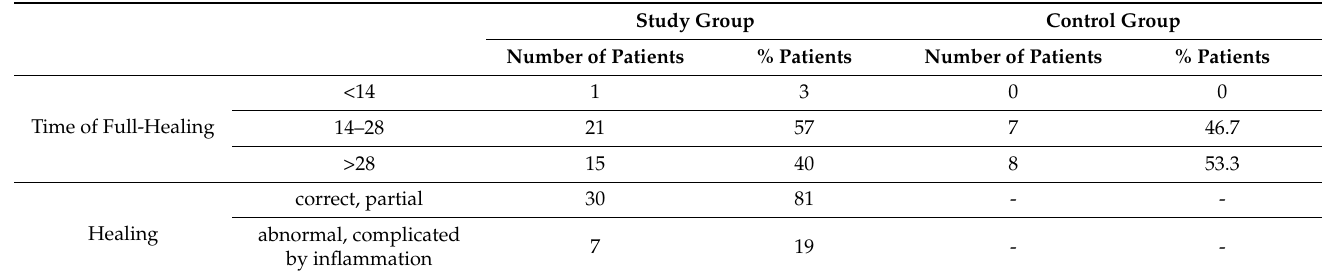
Table 2. Assessment of flap’s healing.